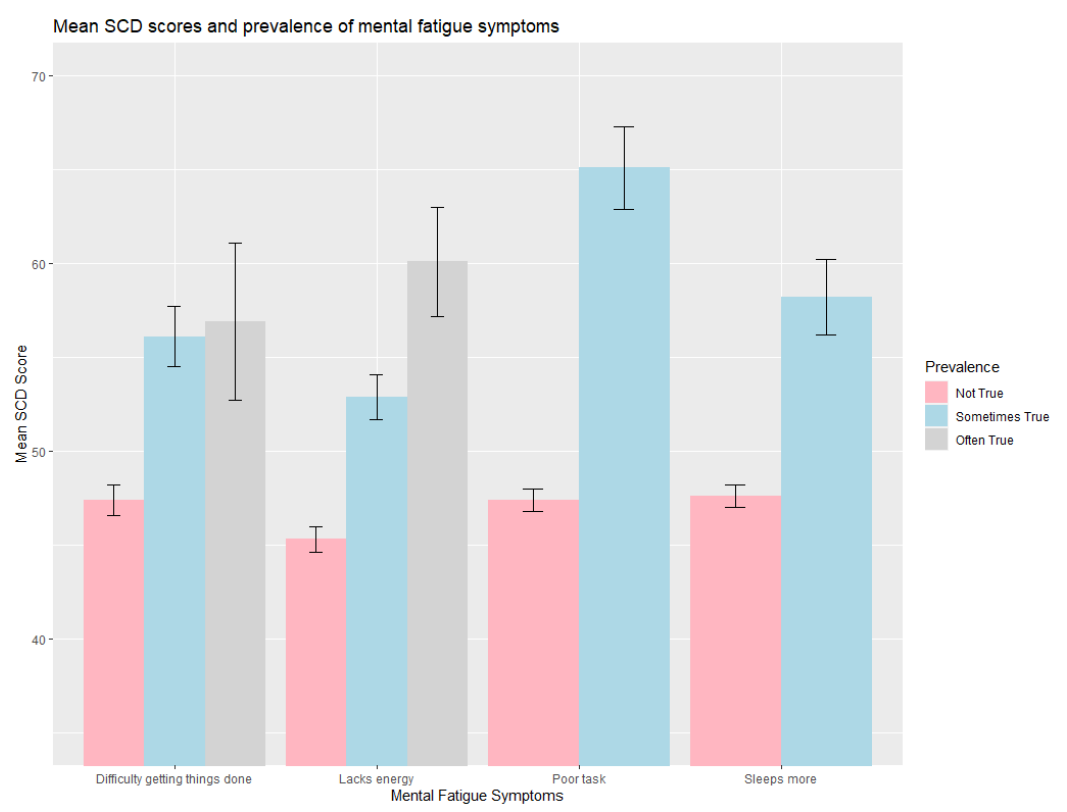
Figure 1. Means of SCD between old adults with and without mental fatigue symptoms. The “Sometimes True” and “Often True” of Poor task and Sleeps more were combined due to the infrequent of “Often True” (<5%). Error bar: 95% confidence interval.